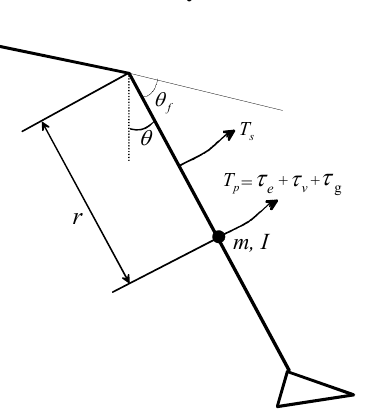
Fig.3. Schematics of skeletal model for pendulum test. T passive torque ( T ) consists of elastic torque ( τ p ) where m and I are the mass and moment of inertia of lower leg, respectively. and torque ( τ g r is the distance from the joint to the lower leng’s center of mass. θ is the segment angle of the lower leg and θ is the flexion angle of the knee f